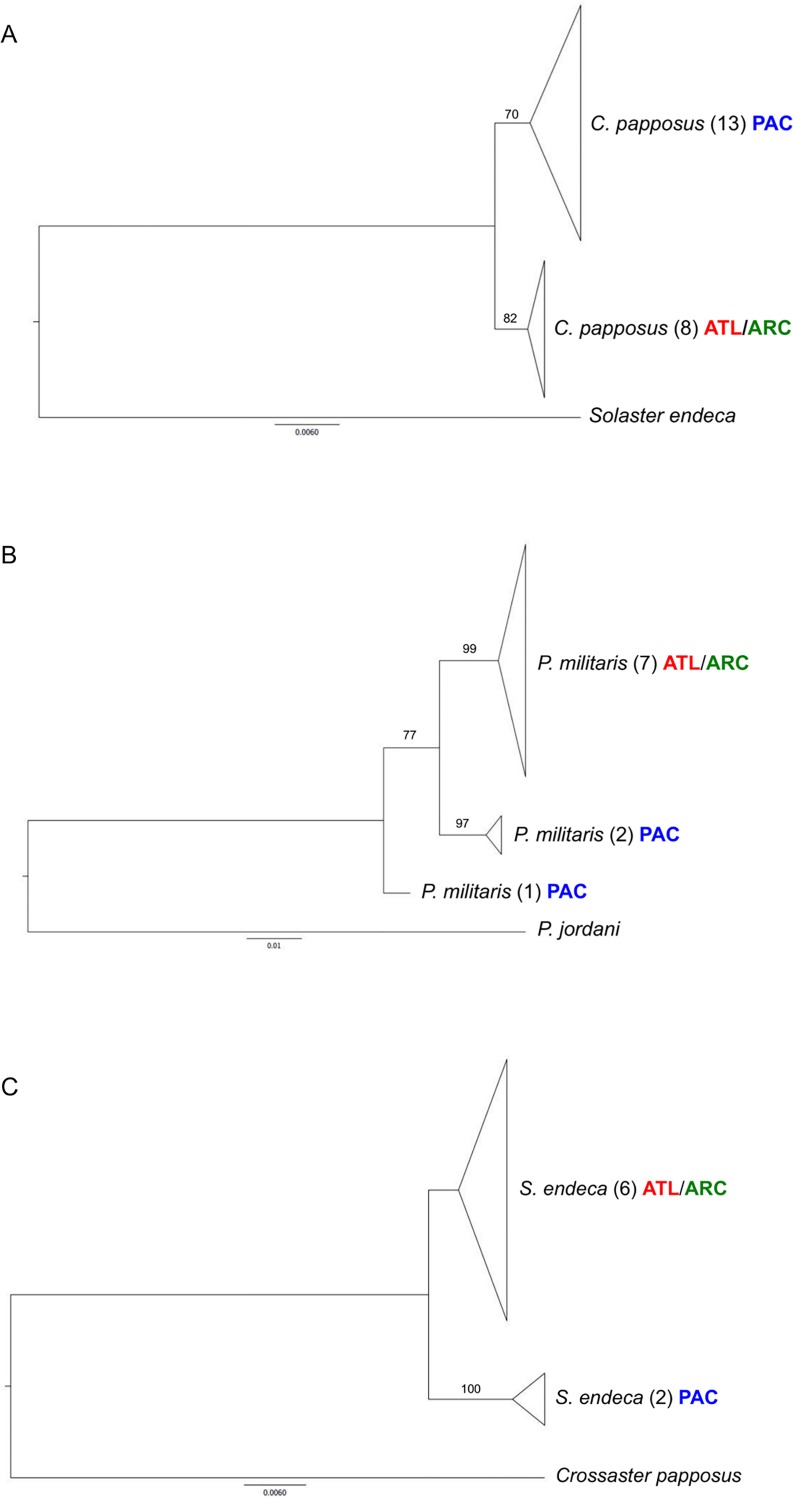
Divergences at COI for three echinoderm species.Maximum-likelihood (HKY+I) trees illustrating population structure at COI in three species of Canadian echinoderms: A) Crossaster papposus, B) Pteraster militaris and C) Solaster endeca. Sequence number is presented in brackets for each clade. Scale bars represent percent sequence divergence.